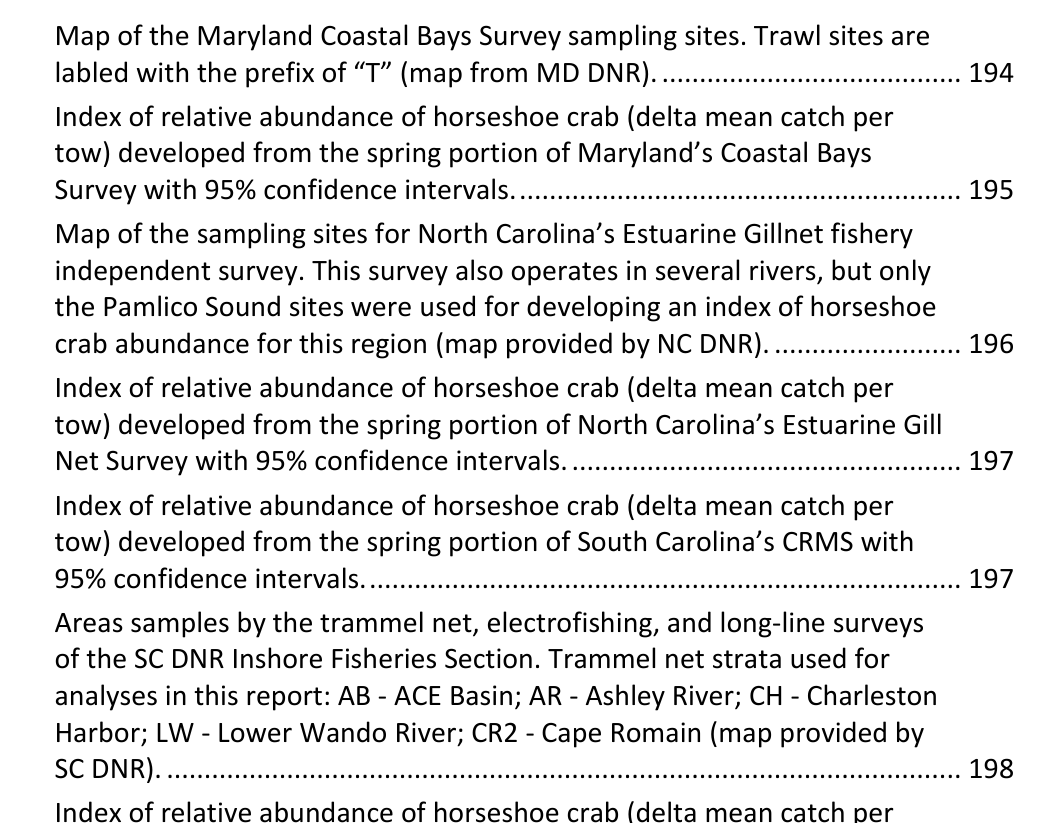
Figure 61. Map of the Maryland Coastal Bays Survey sampling sites. Trawl sites are labled with the prefix of “T” (map from MD DNR). ........................................ 194 Figure 62. Index of relative abundance of horseshoe crab (delta mean catch per tow) developed from the spring portion of Maryland’s Coastal Bays Survey with 95% confidence intervals. ........................................................... 195 Figure 63. Map of the sampling sites for North Carolina’s Estuarine Gillnet fishery independent survey. This survey also operates in several rivers, but only the Pamlico Sound sites were used for developing an index of horseshoe crab abundance for this region (map provided by NC DNR). ......................... 196 Figure 64. Index of relative abundance of horseshoe crab (delta mean catch per tow) developed from the spring portion of North Carolina’s Estuarine Gill Net Survey with 95% confidence intervals. .................................................... 197 Figure 65. Index of relative abundance of horseshoe crab (delta mean catch per tow) developed from the spring portion of South Carolina’s CRMS with 95% confidence intervals. ............................................................................... 197 Figure 66. Areas samples by the trammel net, electrofishing, and long-line surveys of the SC DNR Inshore Fisheries Section. Trammel net strata used for analyses in this report: AB - ACE Basin; AR - Ashley River; CH - Charleston Harbor; LW - Lower Wando River; CR2 - Cape Romain (map provided by Figure 67. Index of relative abundance of horseshoe crab (delta mean catch per tow) developed from the spring portion of South Carolina’s Trammel Net Survey with 95% confidence intervals. ........................................................... 199 Figure 68. States and stations sampled as part of the SEAMAP trawl survey (map provided by SC DNR and SEAMAP). ................................................................ 200 Figure 69. Index of relative abundance of horseshoe crab (delta mean catch per tow) developed from the South Carolina and fall portion of the SEAMAP survey with 95% confidence intervals. ........................................................... 201 Figure 70. Index of relative abundance of horseshoe crab (delta mean catch per tow) developed from the Georgia-Florida and fall portion of the SEAMAP survey with 95% confidence intervals. ........................................................... 201 Figure 71. Map of the survey sites for Georgia’s Ecological Monitoring Trawl Survey (map provided by GA DNR). ............................................................................ 202 Figure 72. Index of relative abundance of horseshoe crab (delta mean catch per tow) developed from the Georgia Trawl survey with 95% confidence intervals. ......................................................................................................... 203 Figure 73. Correlation coefficients and scatter plots for the horseshoe crab abundance indices in the Northeast Region for 1978-2017. All correlations are insignificant ( P >0.05). ........................................................... 204 Figure 74. Correlation coefficients and scatter plots for the horseshoe crab abundance indices in the New York Region for 1987-2016. All